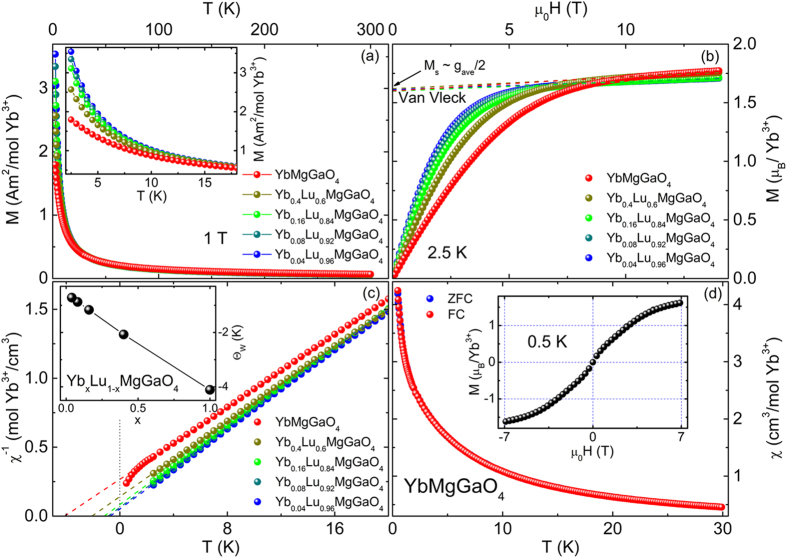
(a) Temperature dependence of magnetization under zero-field-cooling (ZFC) and 1 T in YbxLu1–xMgGaO4. Inset: zoomed view of the low-temperature data. (b) Magnetic field dependence of magnetization at 2.5 K. The colored dash lines show Van Vleck paramagnetism extracted from the linear-field-dependent magnetization data (>10 T). (c) Curie-Weiss fits of magnetization data at low temperatures (<20 K). Inset: fitted (AF) Weiss temperatures. (d) Susceptibilities measured under ZFC and FC from 0.48 to 30 K. No splitting between the ZFC and the FC data was observed at temperatures above 0.48 K. Both the cooling field Hc and the measurement field Hm are 100 Oe. Inset: complete magnetic loop measured at 0.5 K. In both the first and third quadrants, the data collected under increasing fields are perfectly overlapped by those collected during decreasing field.